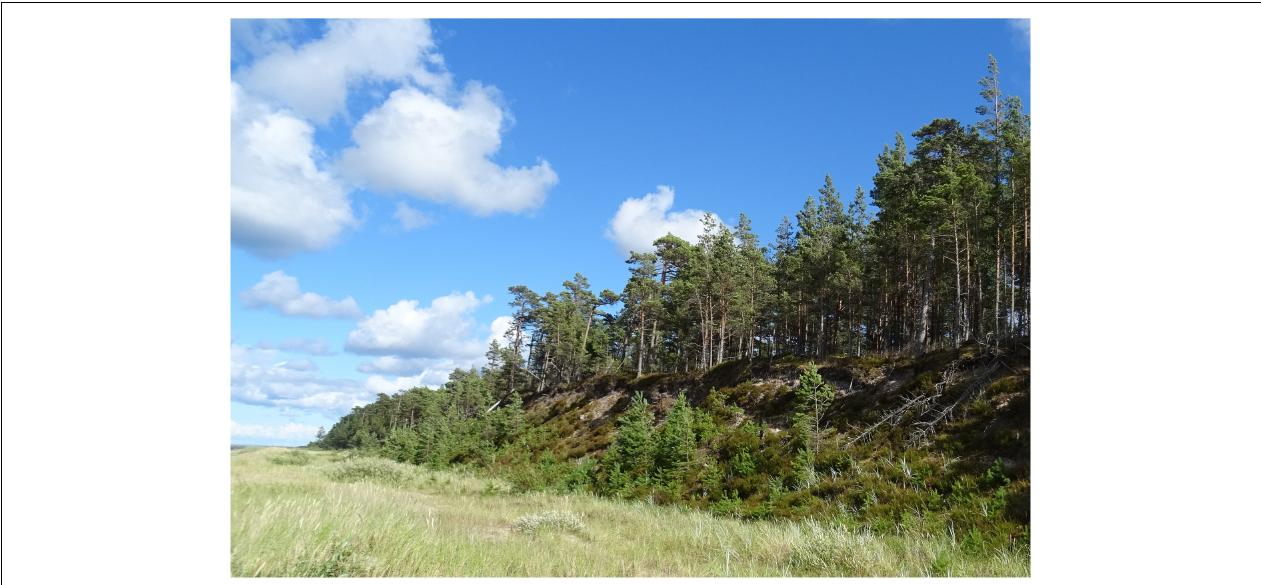
FIGURE 9 | Pines growing on the face of the coastal bluff at the coast between Mazirbe and Kolka (stretch 6, not sampled), where erosion has ceased for an extended period. All photographs by the